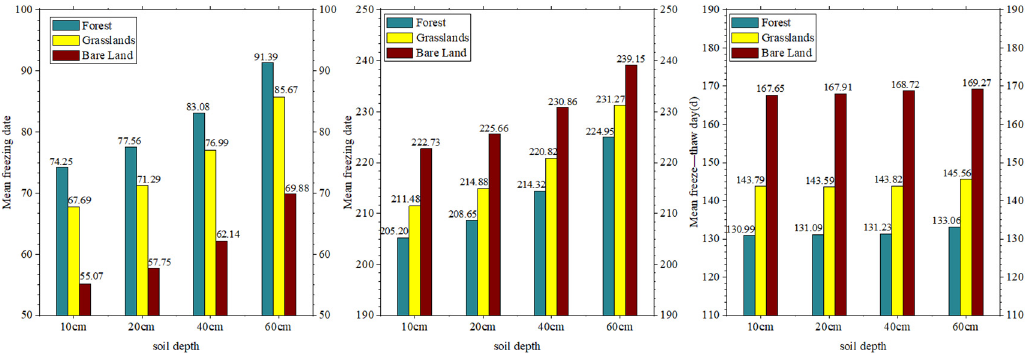
Figure 14. Same as Figure 13, but plotted with respect to vegetation types (unit: day).